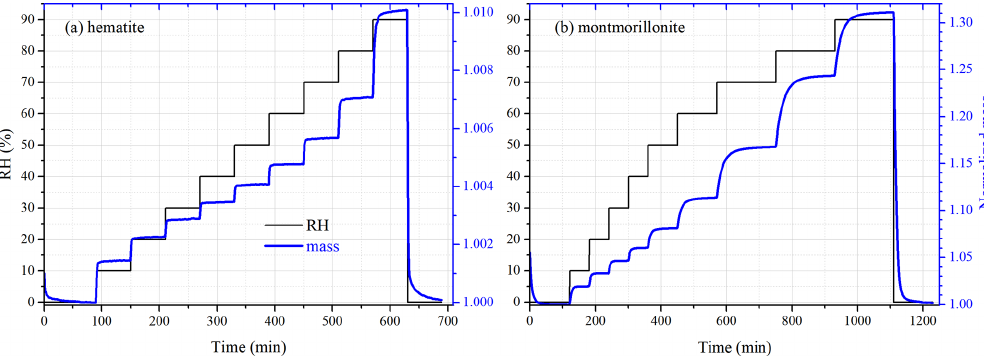
Figure 2. RH (black curve, left y axis) and mass of mineral dust (normalized to that at < 1%RH, blue curve, right y axis) as a function of experimental time: (a) hematite and (b)